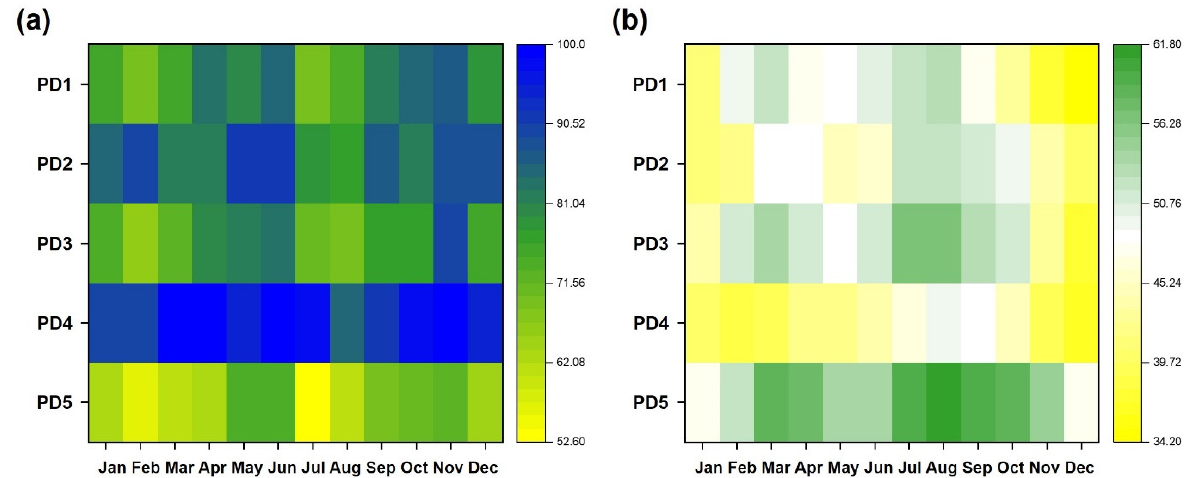
Figure 5. Temporal variations (heat map) graphic of Korean water quality indicators in the PDR. ( a ) RTWQI; ( b ) TSI KO .